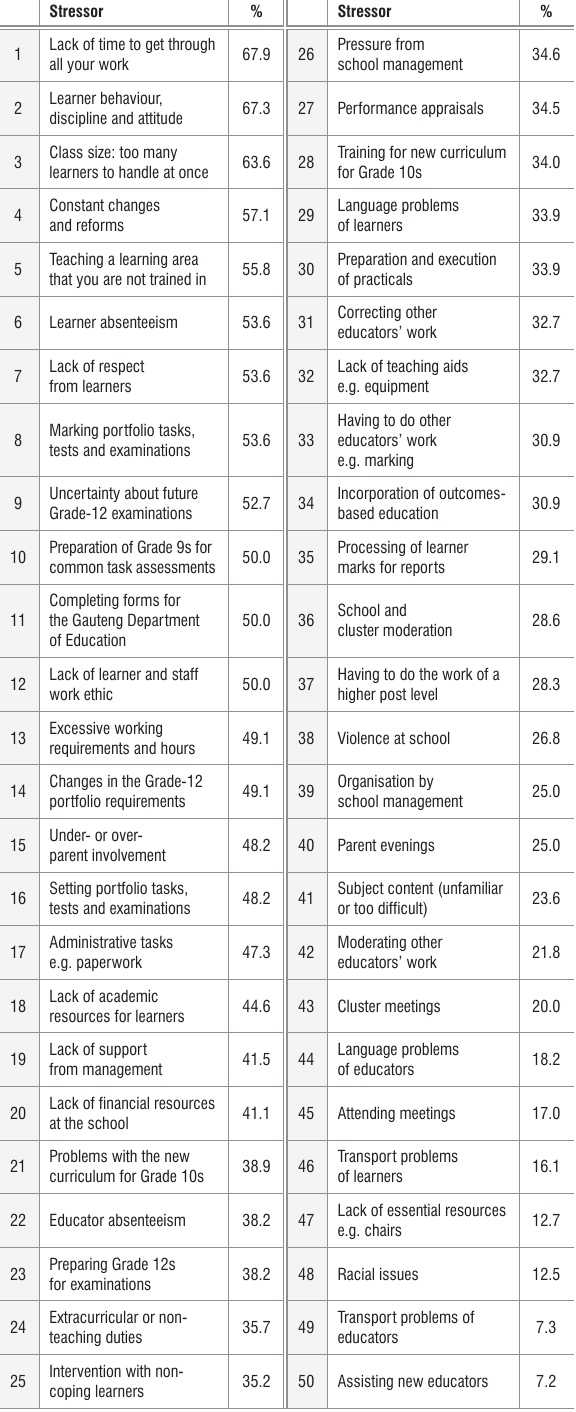
Percentage of educators who rated each stressor as a